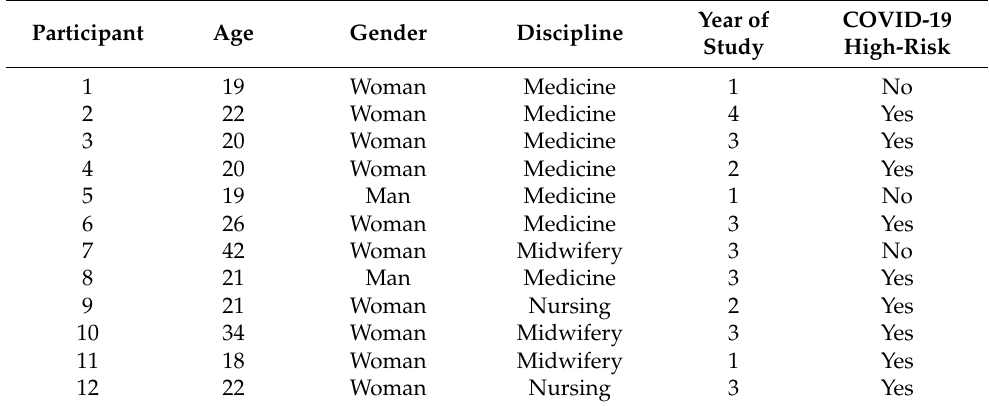
Table 1. Participant characteristics.